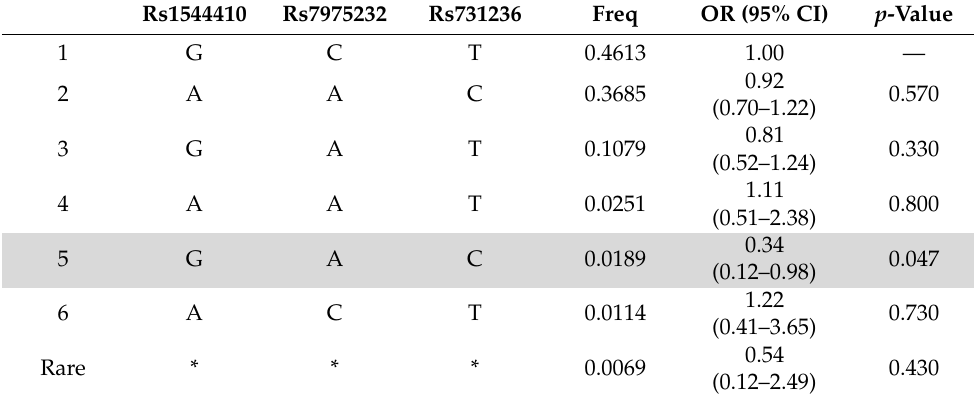
Table 4. Haplotype association with